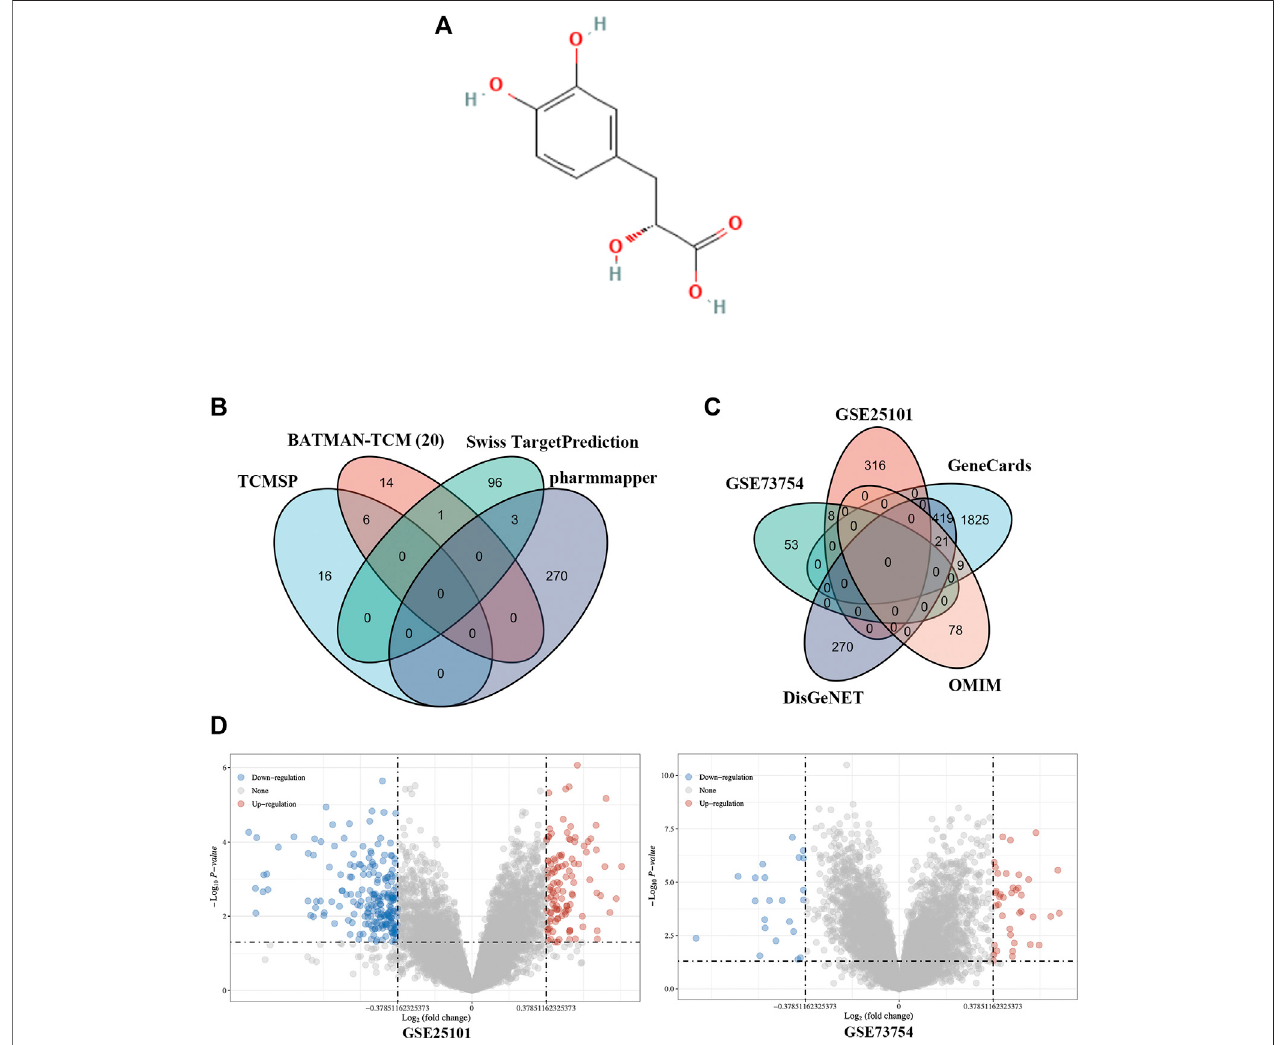
FIGURE 2 | Identi fi cation of Danshensu targets and AS-related genes. (A) Chemical structure of Danshensu. (B, C) Venn diagram of Danshensu targets (B) and AS-related genes (C) . (D) Volcano plot of DEGs obtained from GSE25101 and GSE73754.